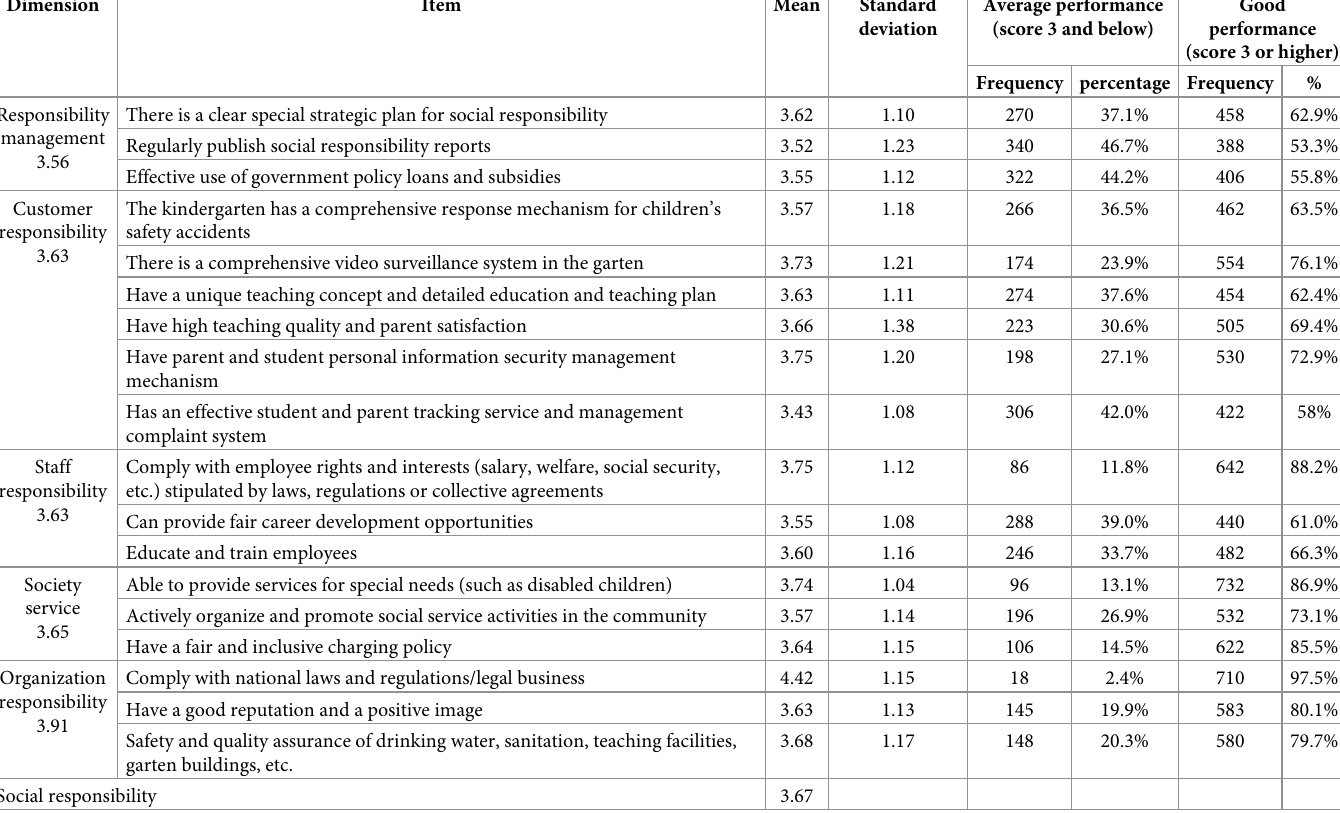
Table 4. Status of the fulfillment of social responsibilities of Puhui